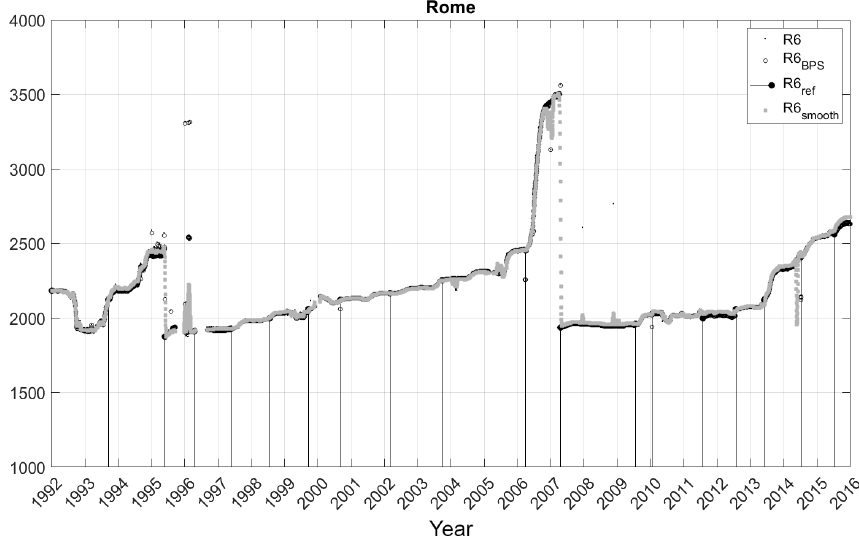
Figure 8. Daily series of the ratios R 6, R 6 BPS and R 6 smooth _3000 (setting the SL maximal limit to 3000 units, in the legend named R 6 smooth ) at Rome. Vertical lines represent R 6 ref established during each calibration campaign.